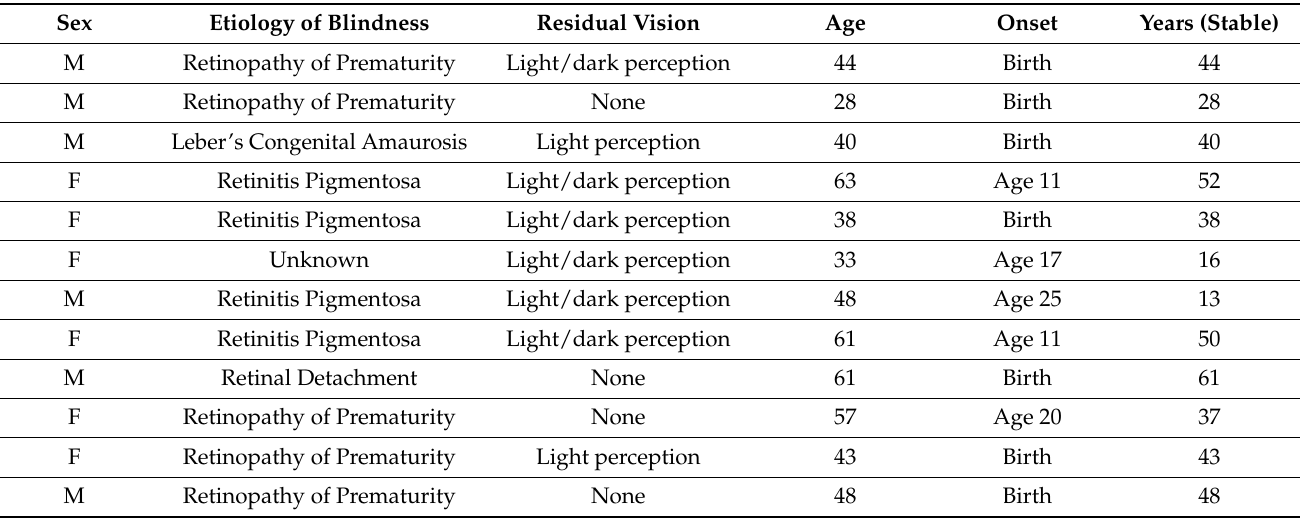
Table 2. Demographic details of the BVI